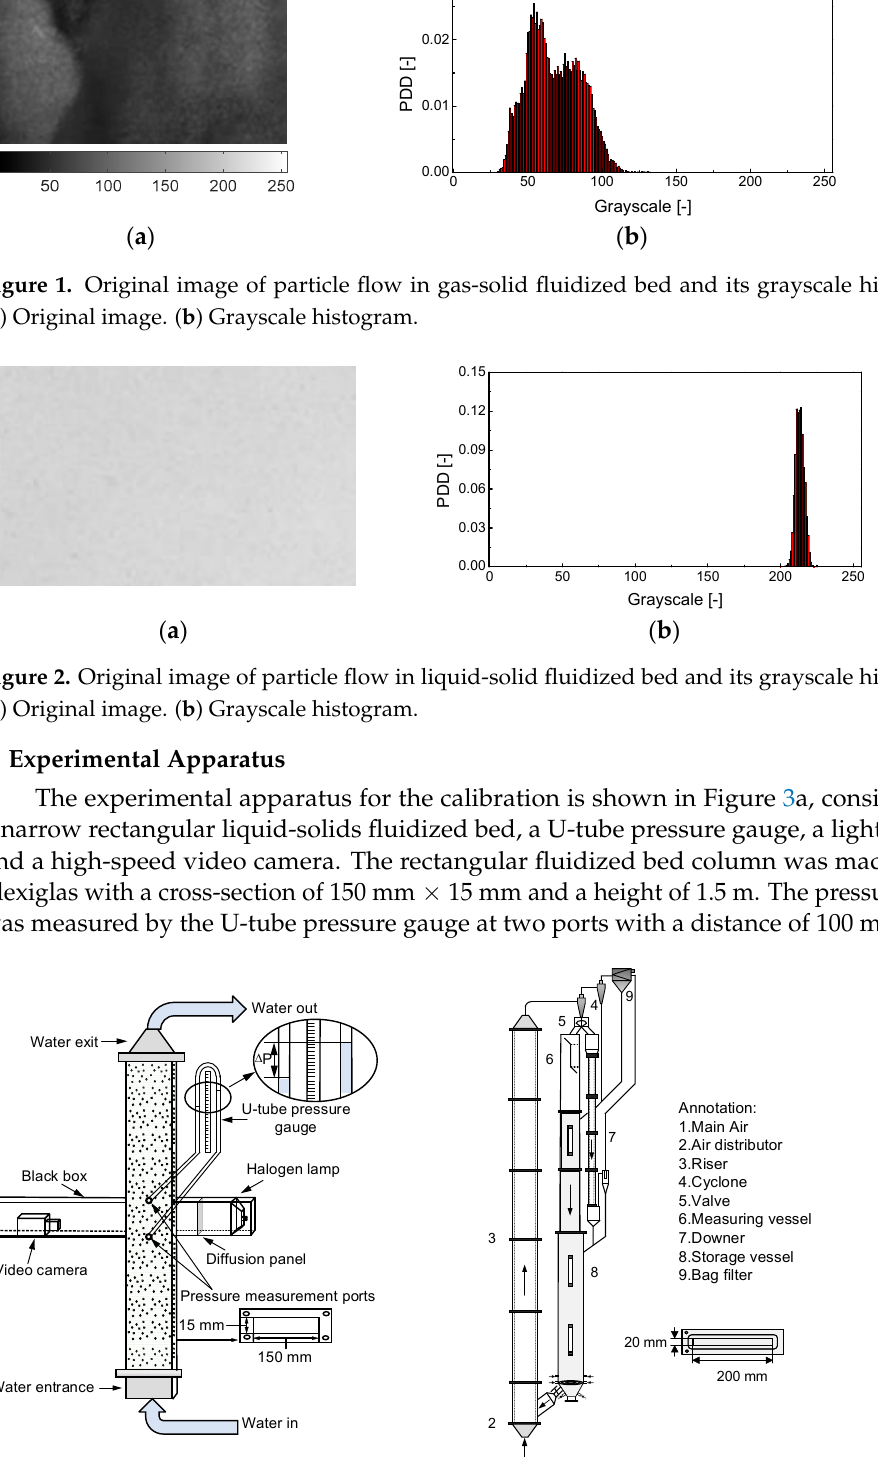
Figure 3. Schematic diagram of the calibration system and the fluidized bed for image collection. ( a ) Liquid ‐ solids fluidized bed for calibration. ( b ) Gas ‐ solids fluidization system for image collection. ( a ) Liquid-solids fluidized bed for calibration. ( b ) Gas-solids fluidization system for image